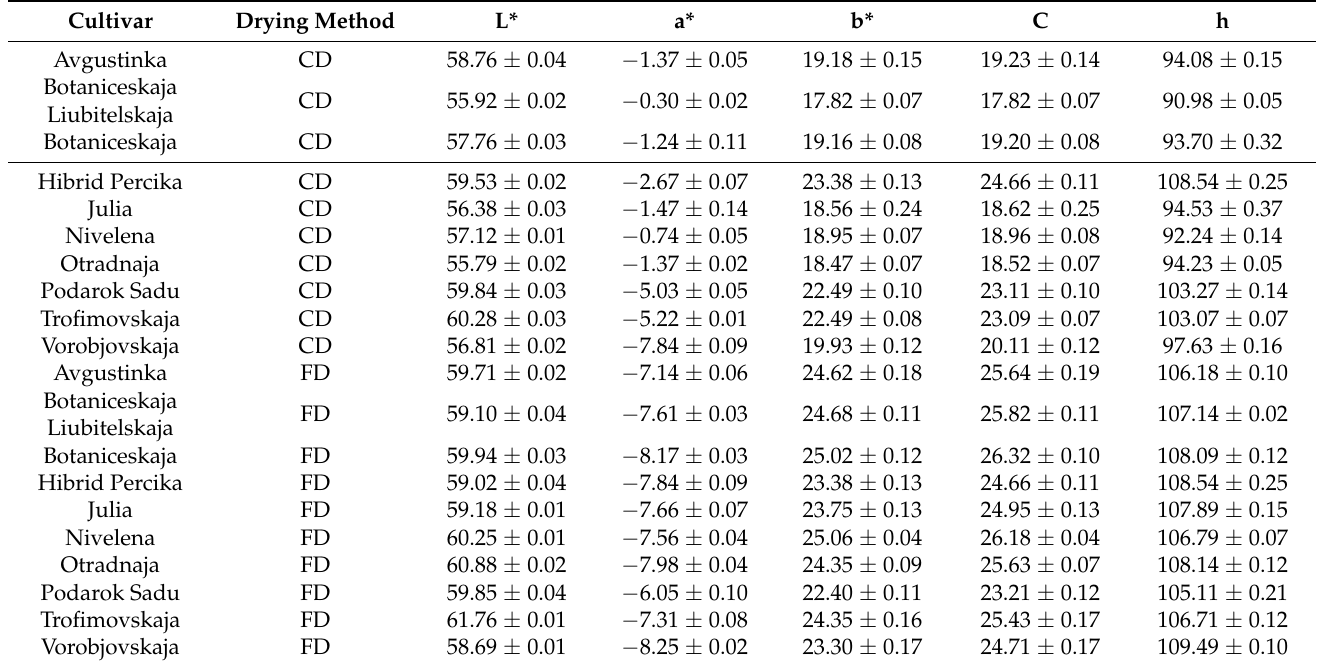
Table 1. The chromatic characteristics (L*, a*, b*, C, and h) of convection-dried (CD) and freeze-dried (FD) HR cultivars’ leaf